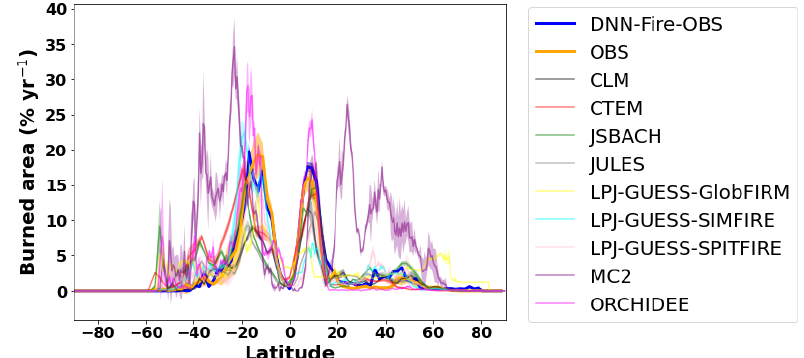
Figure 7. Prognostic simulation of wildfire burned area (2011–2015) with the deep neural network wildfire model fine-tuned with observa- tions (DNN-Fire-OBS) compared with observations and nine FireMIP models